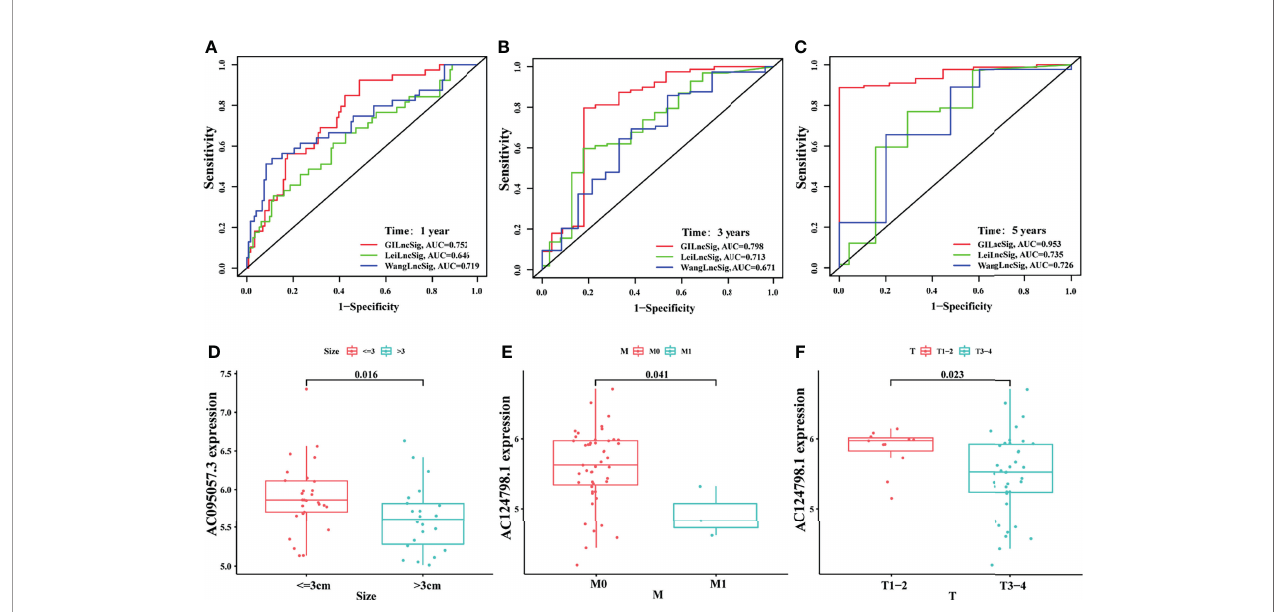
FIGURE 7 | Comparison and external veri fi cation of the signature. The ROC analyses of overall survival at 1- (A) , 3- (B) , and 5- (C) year for the GILncSig, LeiLncSig, and WangLncSig. Relationship between AC095057.3 and tumor size (D) ; between AC124798.1 and M stage (E) , and T stage (F) in GSE102238